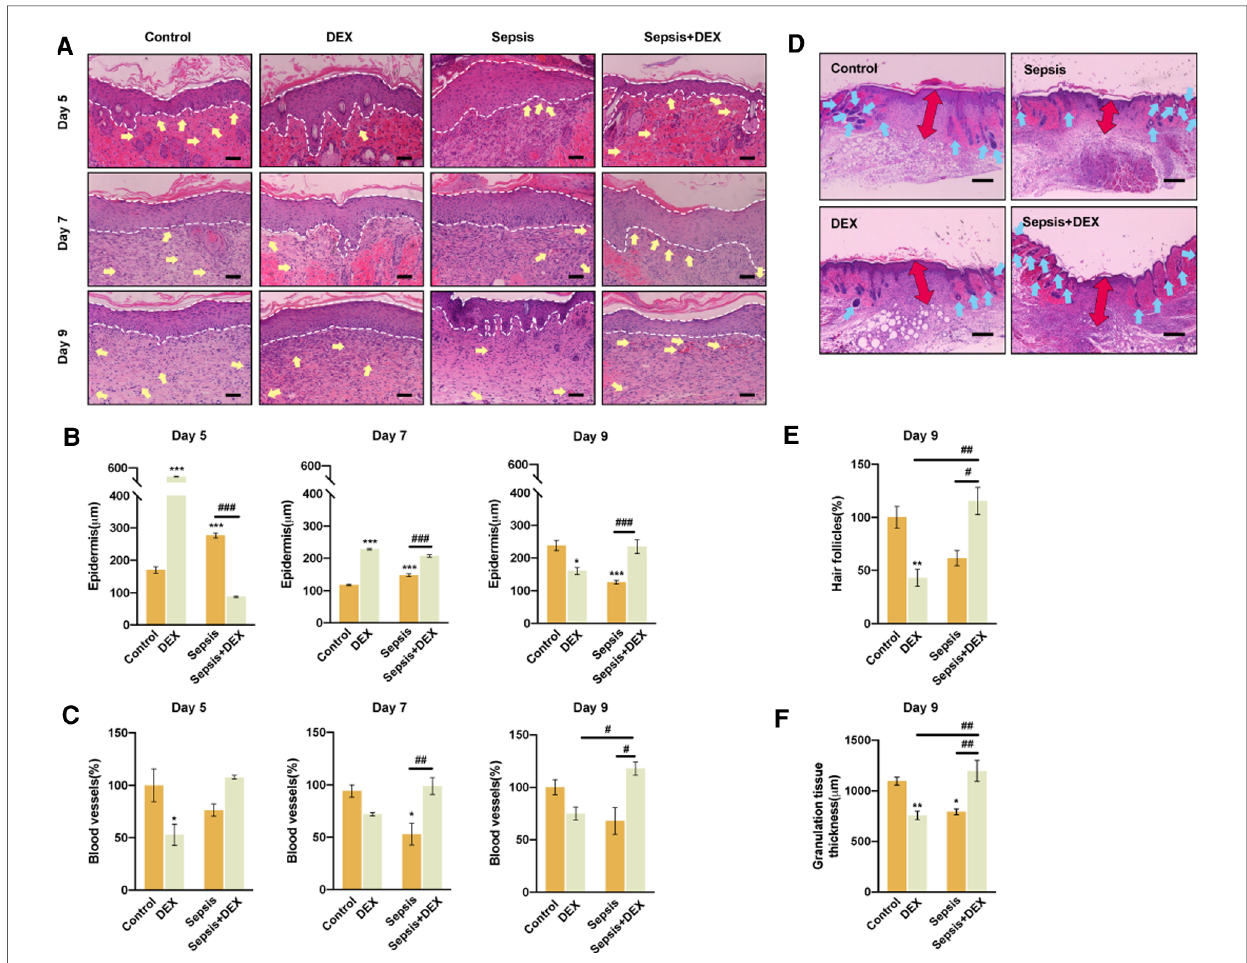
FIGURE 4 Intraperitoneal injection of dexamethasone (1 mg/kg) improved tissue regeneration in septic mice. ( A ) Wound H&E staining for control, sepsis, DEX, and sepsis+DEX on the 5 th , 7 th , and 9 th day (blood vessels: yellow arrows, hair follicles: blue arrows, boundary of epithelium: white lines). Scale bar: 100 µm. ( B ) Epidermis thickness assessments for different groups on the 5 th , 7 th , and 9 th day. ( C ) Blood vessels regeneration on the 5 th , 7 th , and 9 th day. Quanti fi ed data were presented by relative number percentage. Control group on 5 th day was set as 100%. ( D ) Granulation tissue (red arrows) thickness and amount of hair follicles (blue arrows) for different groups on the 9 th day. Scale bar: 500 µm. ( E ) Hair follicles for different groups on day 9 post- wounding. Data were shown in relative number percentage. Control group was set as 100%. ( F ) Quantitative data of granulation tissue thickness. Data are shown as mean±SEM, n =3.* P <0.05, ** P <0.01, *** P <0.001, vs. control group; # P <0.05, ## P <0.01, ### P <0.001, vs. other